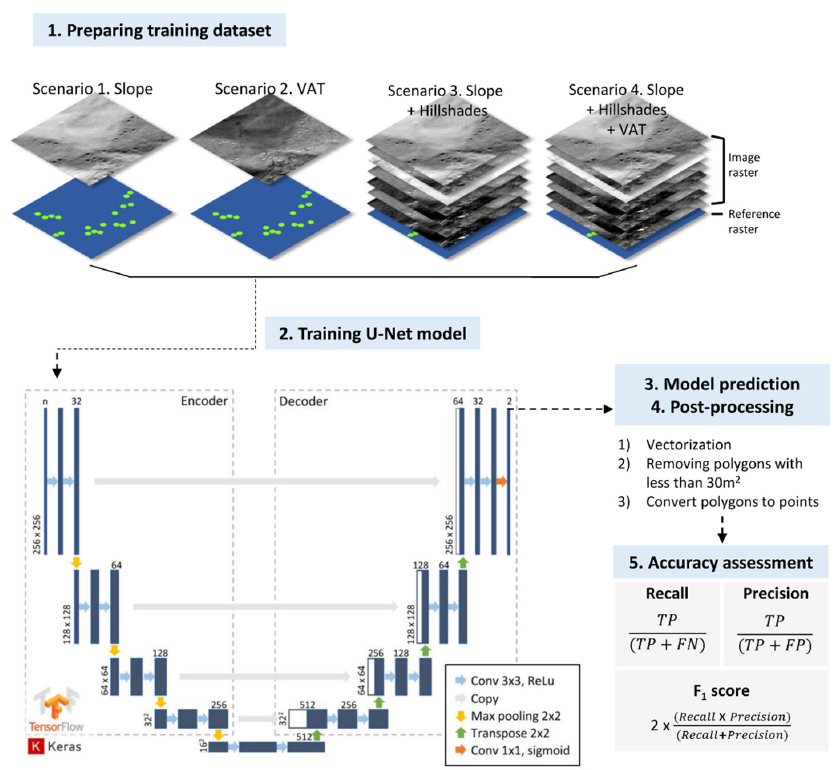
Figure 4. The workflow of automated RCH detection using U-Net.